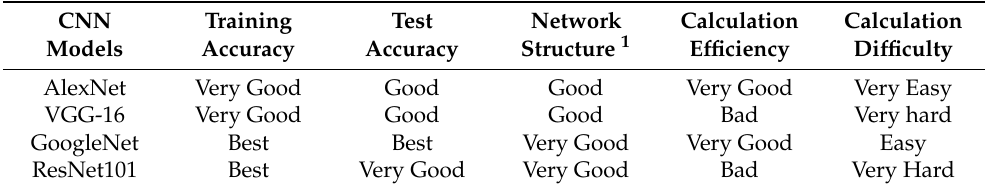
Table 5. Comprehensive comparison of the CNN